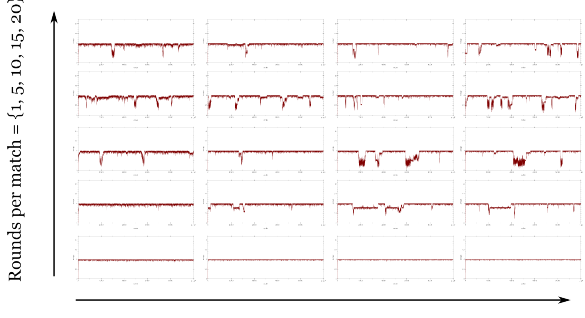
Figure 4: Population mean over cycles, different learning rate and rounds per match. The bottom 4 are of the one-shot game, others are of the repeated.